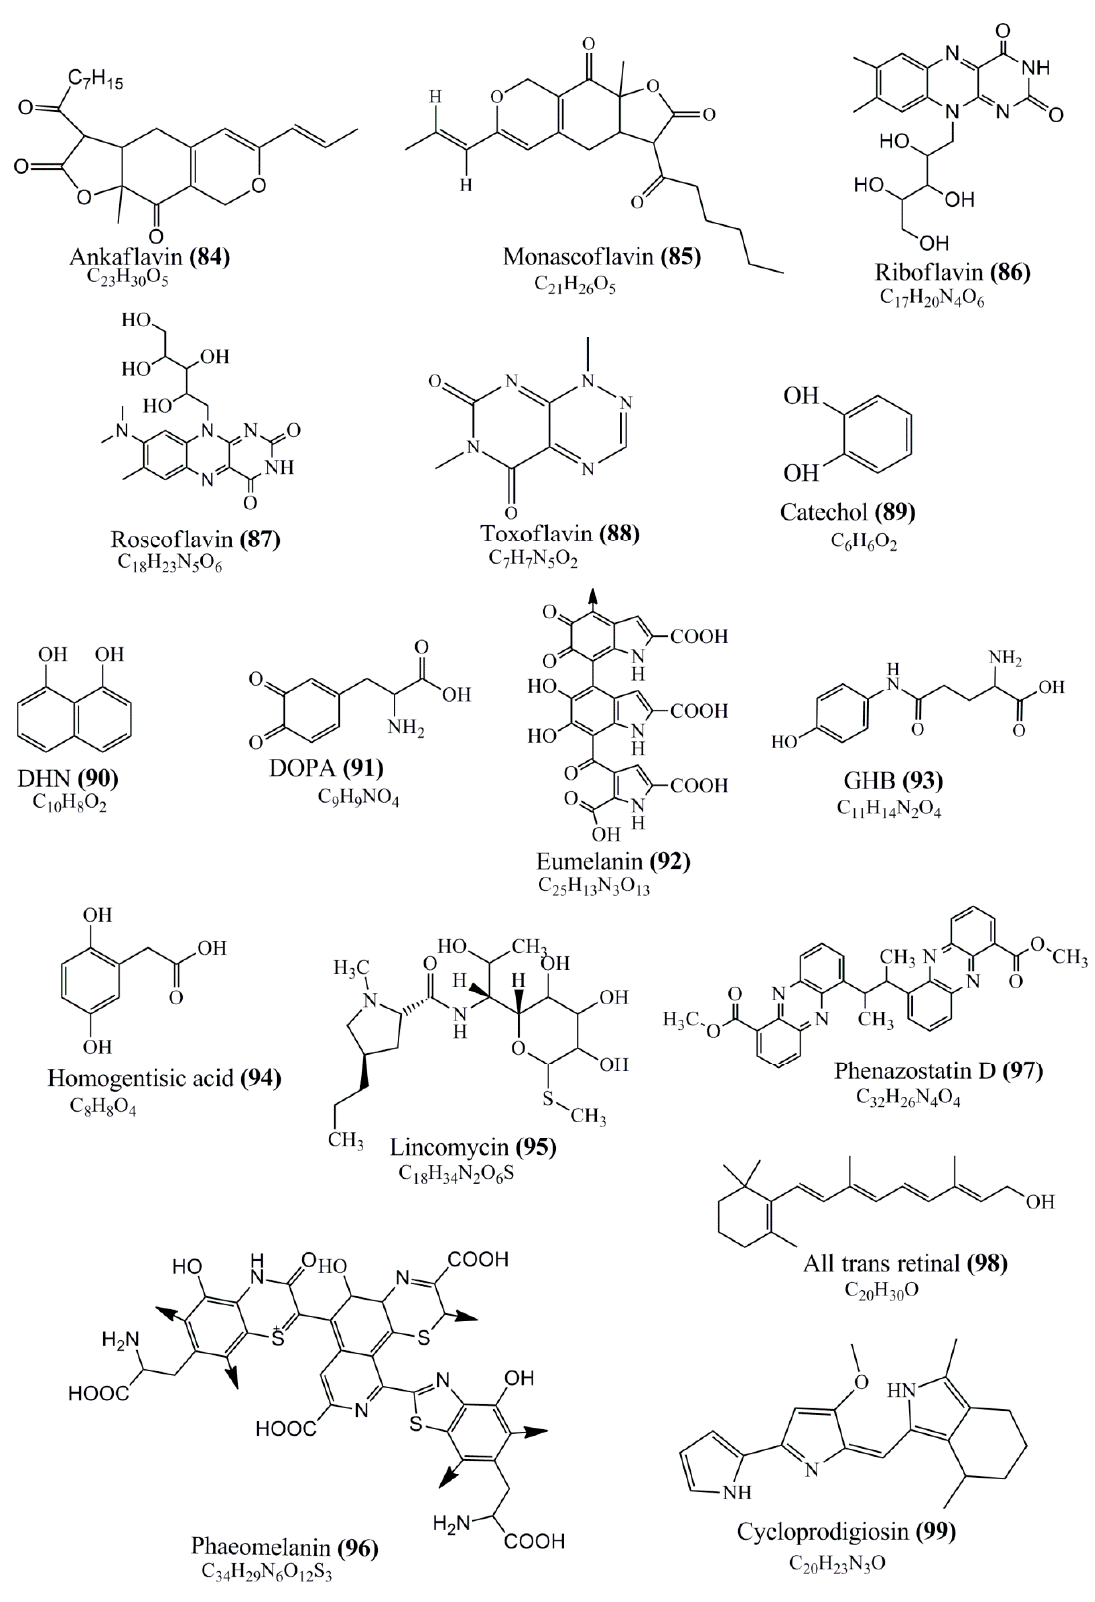
Figure 1. Figure 1. Continued.